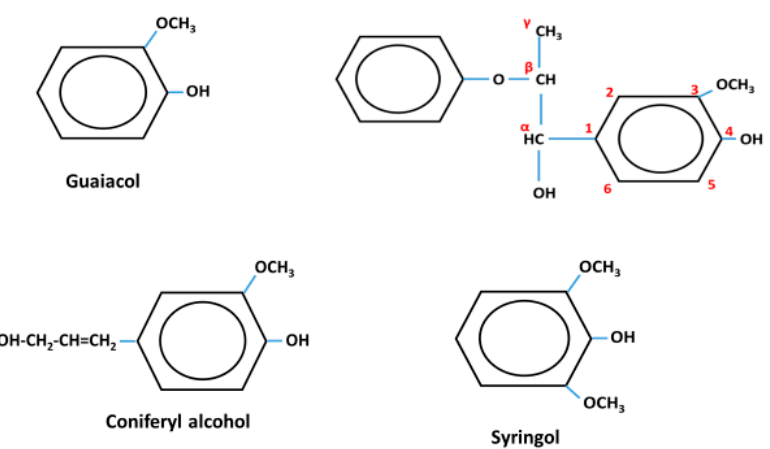
Figure 1. The monomers and numbering system used in lignin.